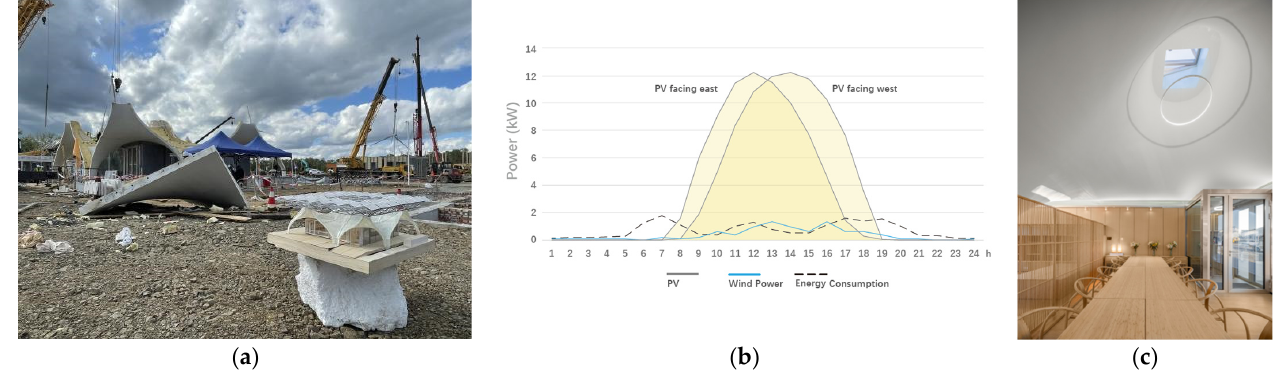
Figure 15. Main results of the Solar Ark 3.0. ( a ) UHPC prefabrication. ( b ) Energy production and consumption. ( c ) Skylight.